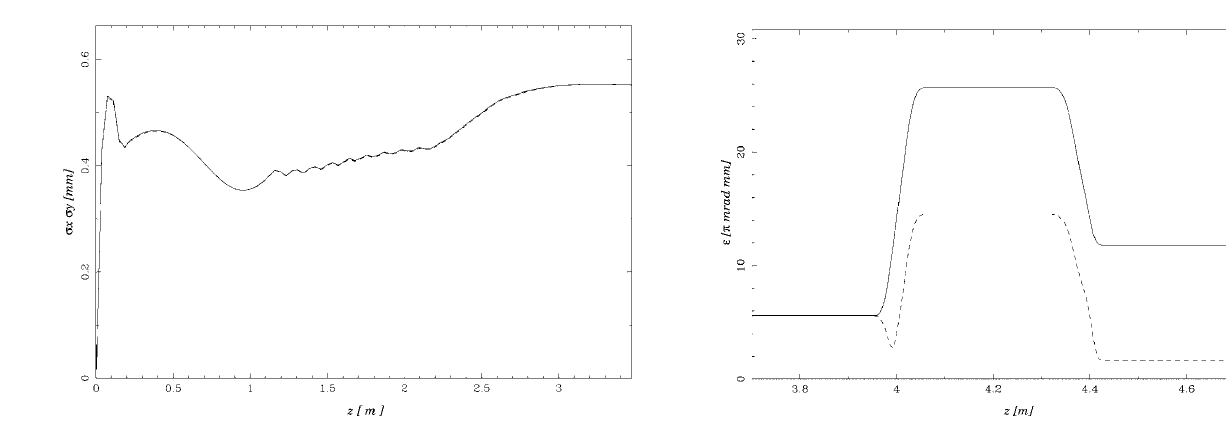
FIG. 6. Evolution of the horizontal (solid line) and vertical (dashed line) beam emittances in the skew quadrupole